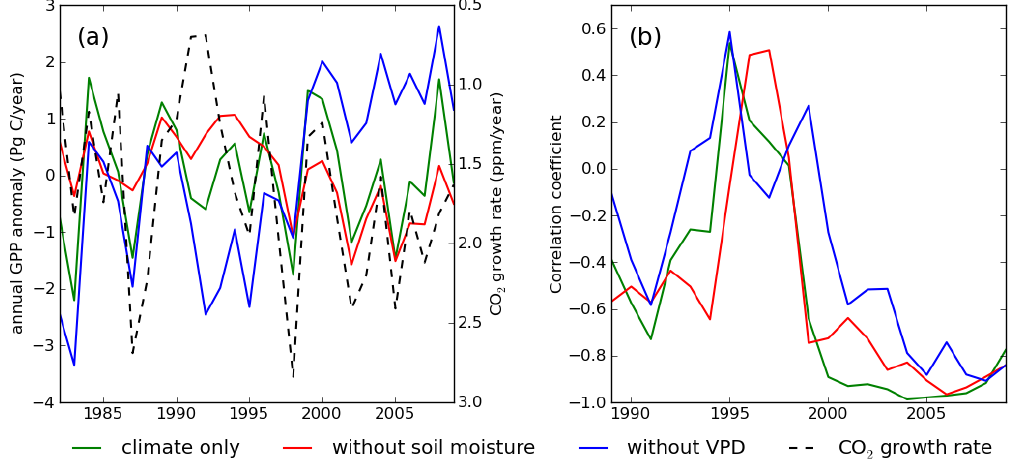
Figure 2. ( a ) Anomaly of global GPP estimated by the climate only run ( S_clim ), climate only run without soil moisture control ( S_wo_sm ), and climate only run without Vapor Pressure Deficit (VPD) control ( S_wo_vpd ). The time series of the CO growth rate is 2 shown with the black dashed line. ( b ) Time series of the correlation coefficient between GPP of the three simulations and CO growth rate for the past 7 2